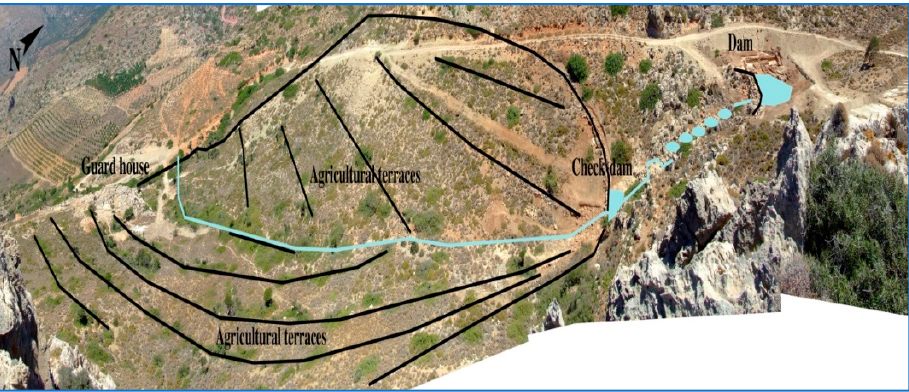
Figure 2. The main dam, the check dam, and the irrigated agricultural terraces in Choiromandres (modified from [23]). (modified from